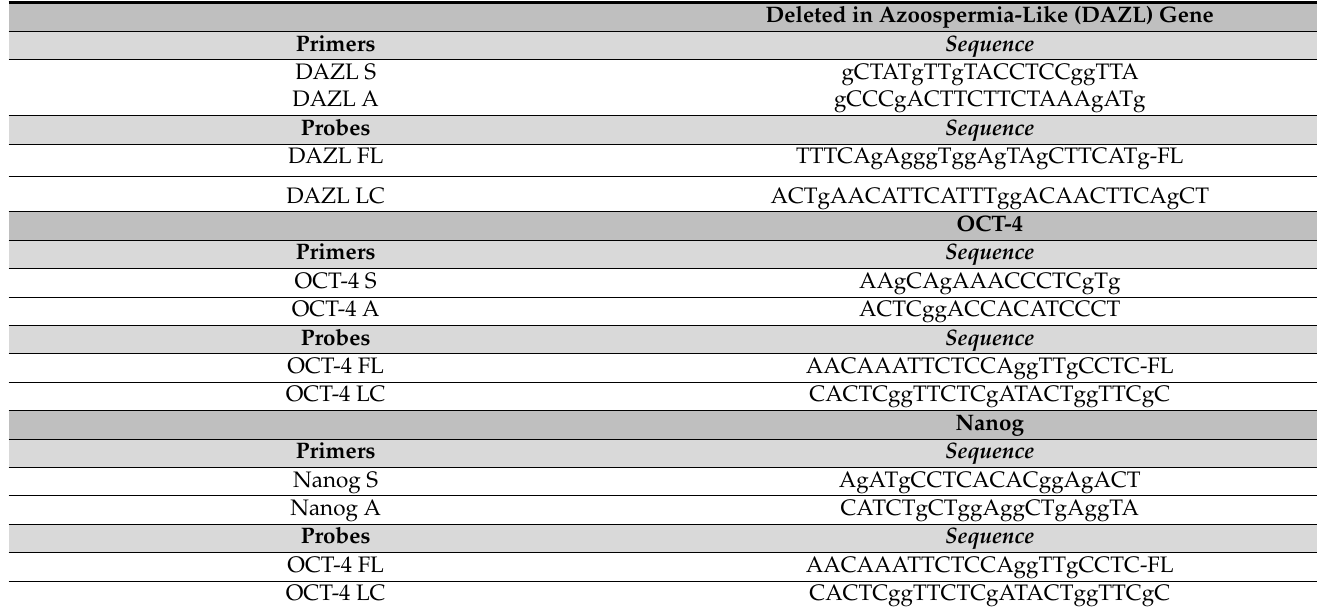
Table 1. Oligonucleotides used during Real Time